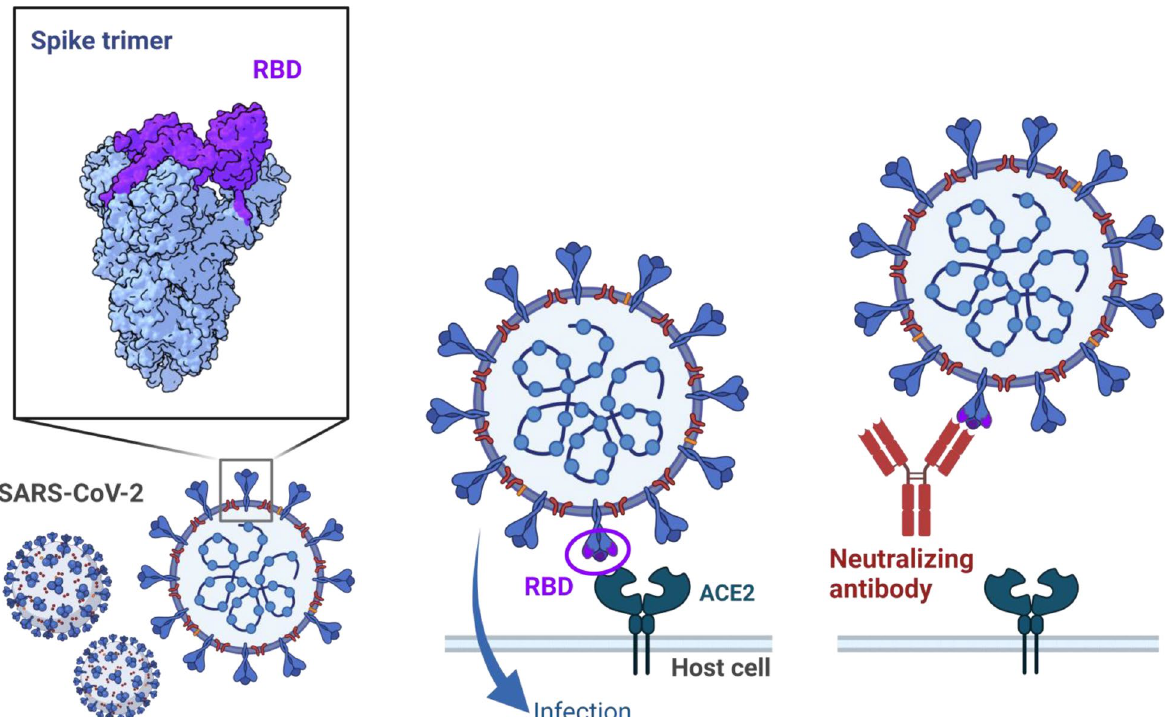
Fig. 2 Antibody-dependent neutralization of SARS-CoV-2 entry through RBD. SARS-CoV-2 infection through RBD of spike proteins and neutralization by a protective antibody are depicted. The structural analysis on trimeric spike protein (upper left) is visualized with UCSF ChimeraX software (Refs. [35, 36]) using data from PDB (PDB ID: 6VSB, https:// doi. org/ 10. 2210/ pdb6V SB/ pdb, Ref. [37]). The figure was created with